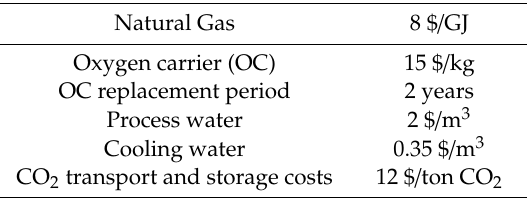
Table 2. Variable O&M cost assumptions.